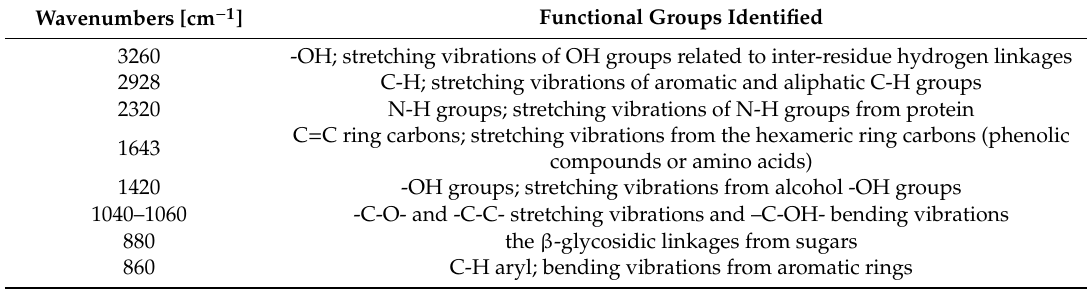
Table 1. Distribution of the main peaks at FT-IR spectra of proteolysed EPS ( P ) obtained from cultures of three F. culmorum strains: DEMFc2, DEMFc5, and